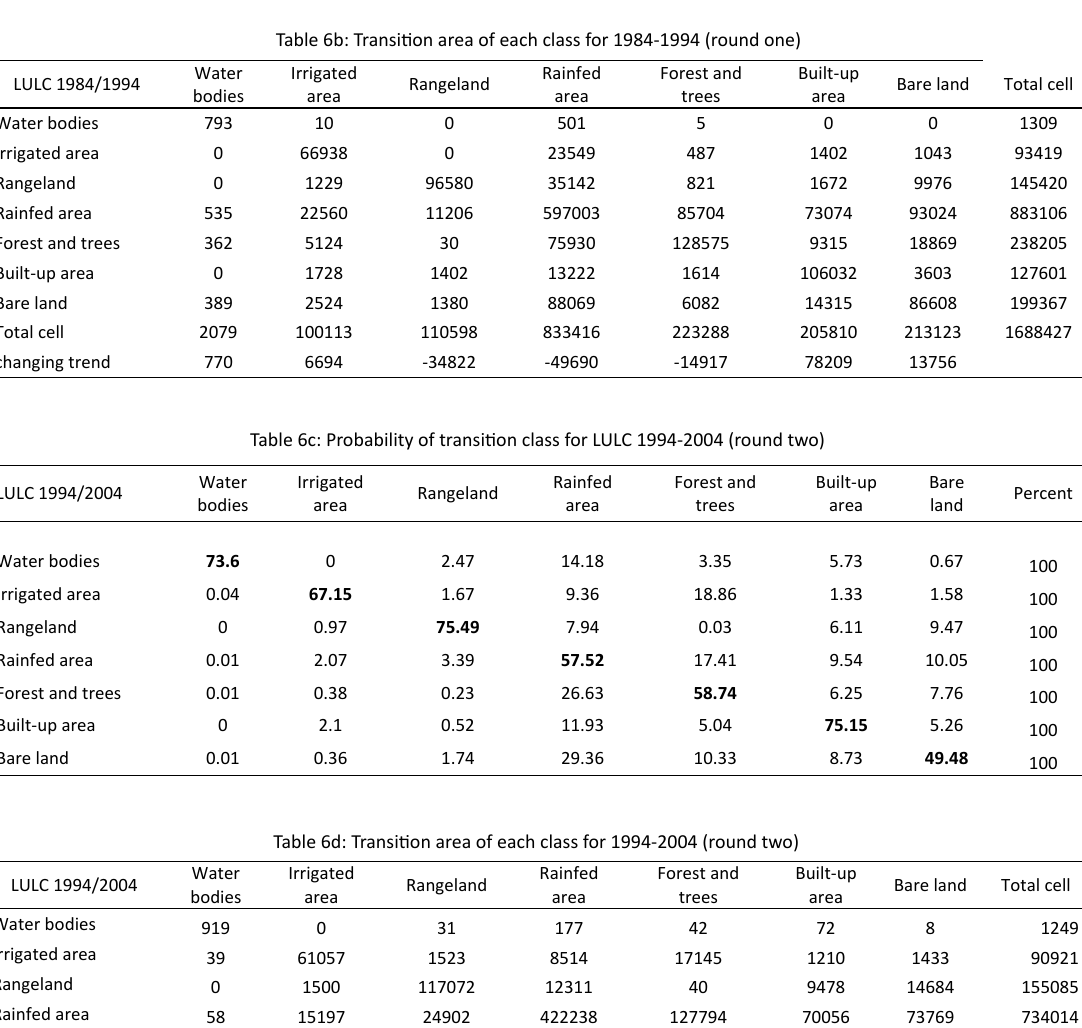
Table 6b: Transition area of each class for 1984-1994 (round one)